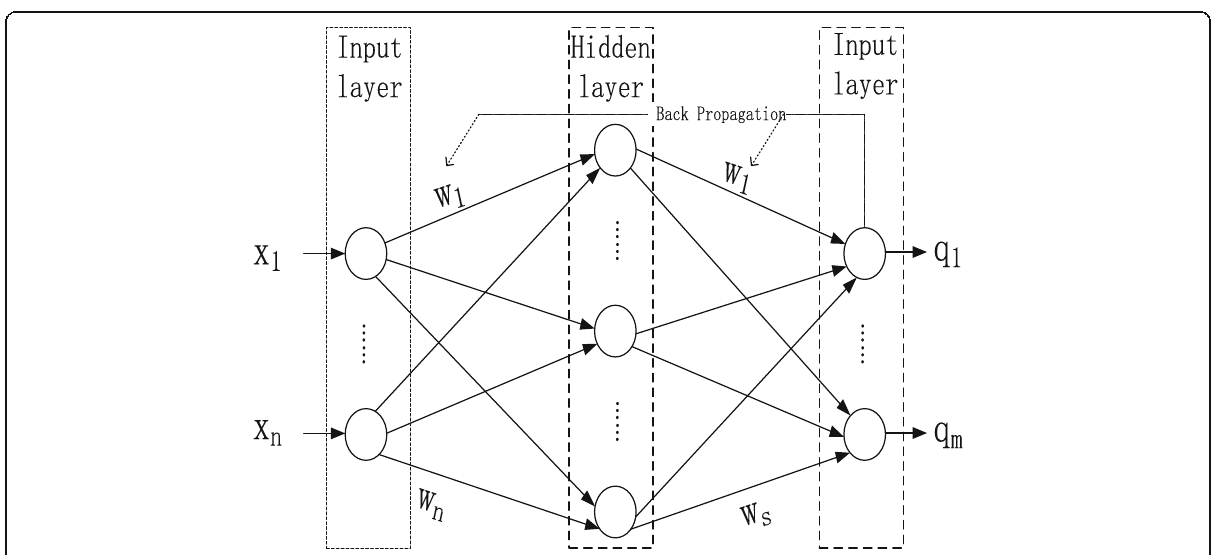
Fig. 1 The structure of a three-layer BP neural